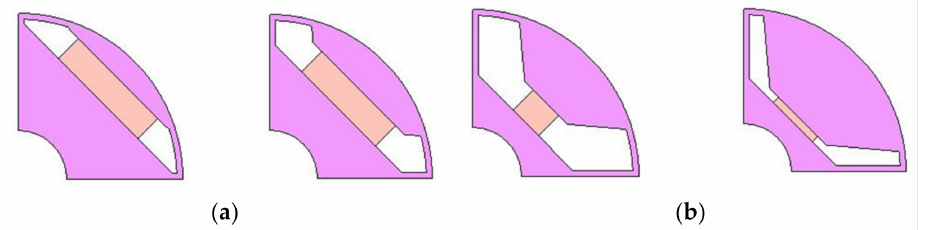
Figure 2. Example IPMSM rotor geometries for ( a ) high torque positive and ( b ) extremely low torque negative